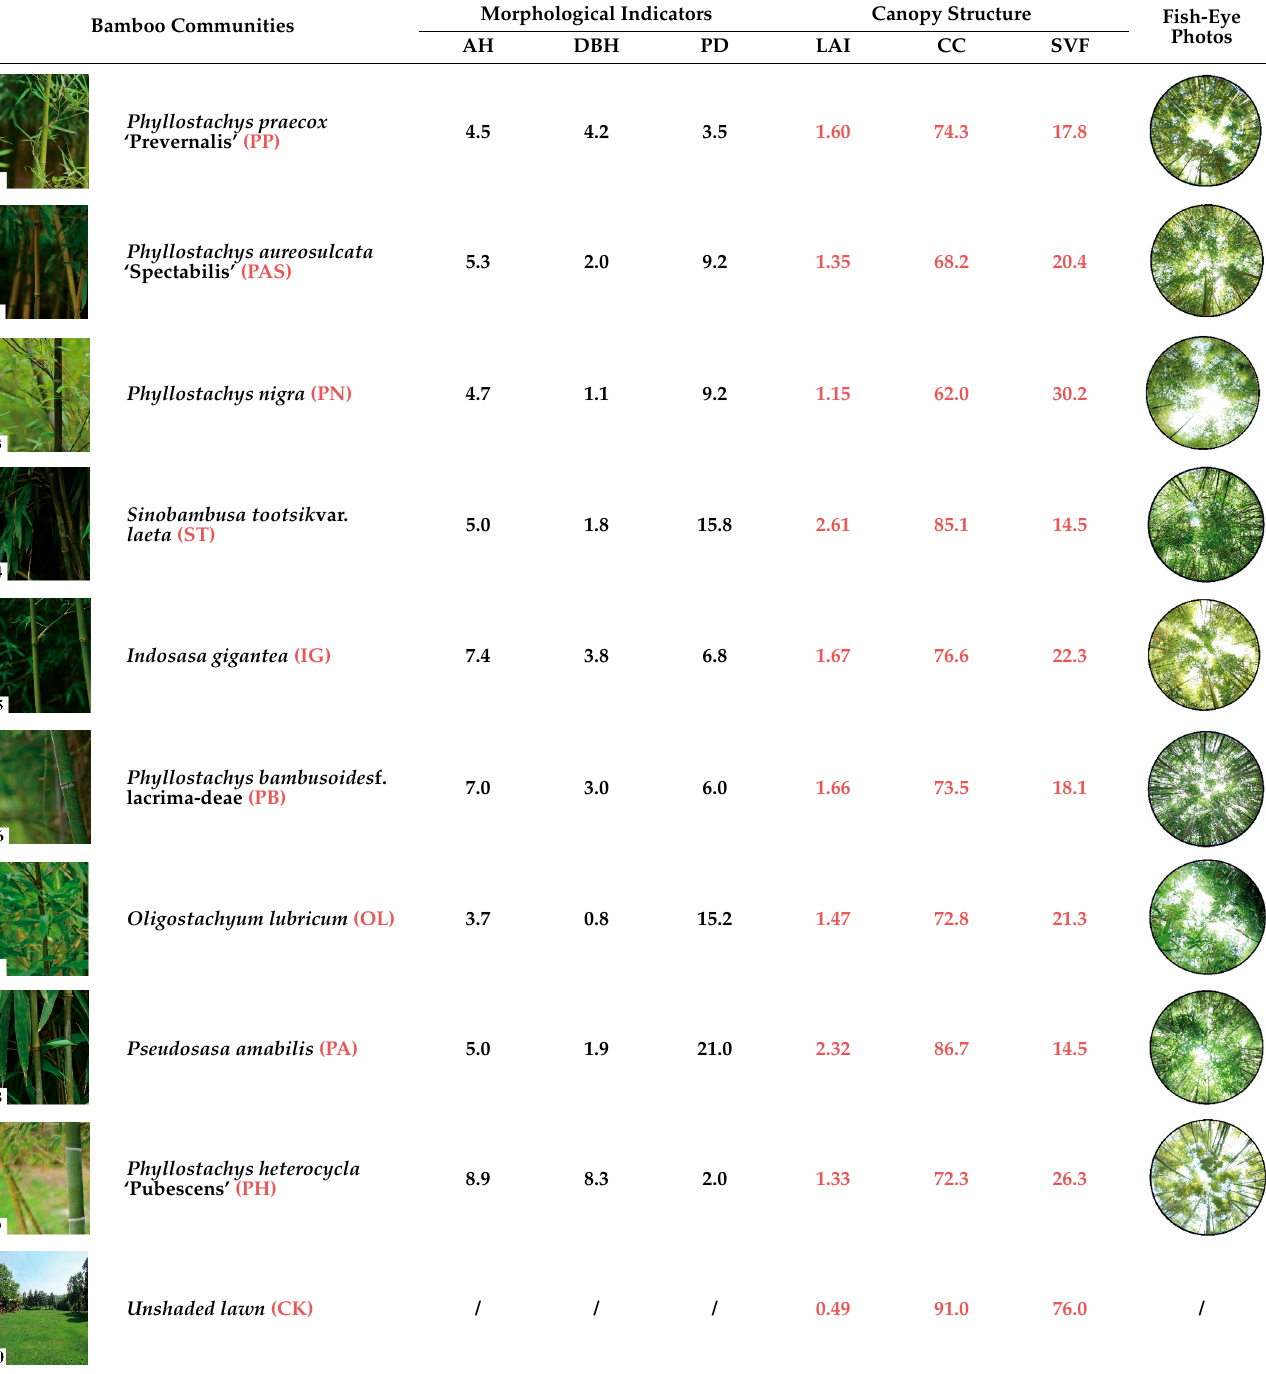
Figure 1. Map of the study area and measurement sites. Table 1. Morphological indicators, canopy structure data, and photos of bamboo communities. AH: average height (m); DBH: diameter at breast height (cm); PD: planting density (T·m − 2 ), T: tree; LAI: leaf area index; CC: canopy coverage (%); SVF: sky view factor (%).